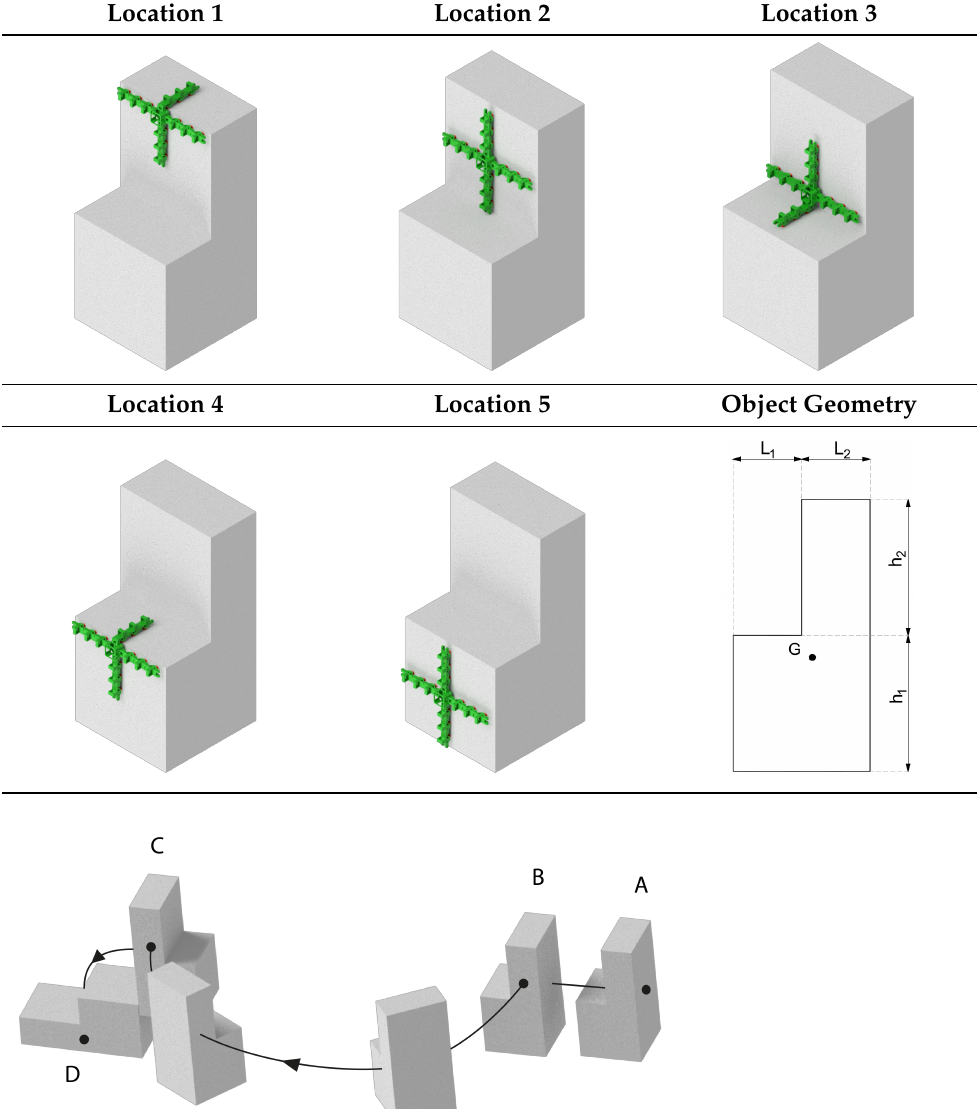
Figure 11. Schematic representation of the trajectory followed by the irregular prism. It simulates a robot that picks an object from a shelf (AB); then, after a rotation of the whole robot (BC), the object is placed rotated 90 degrees